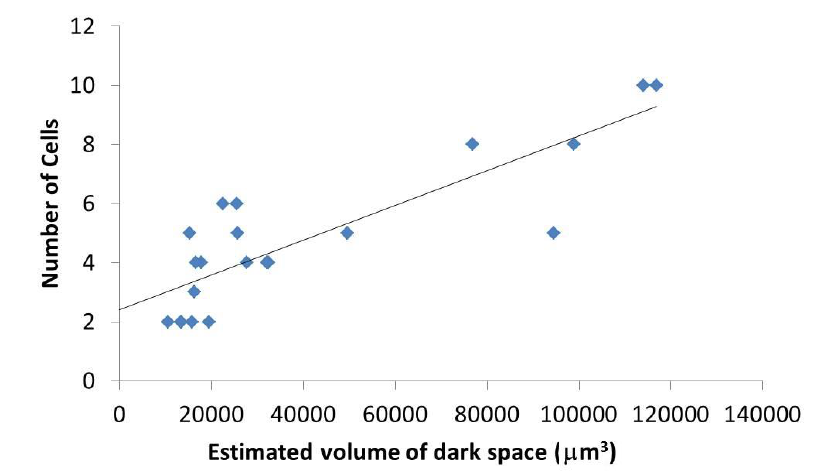
Fig. 6 Relationship between the number of constituent cells in aggregations and the estimated volume of dark spaces in SHG images. The black line represents the linear